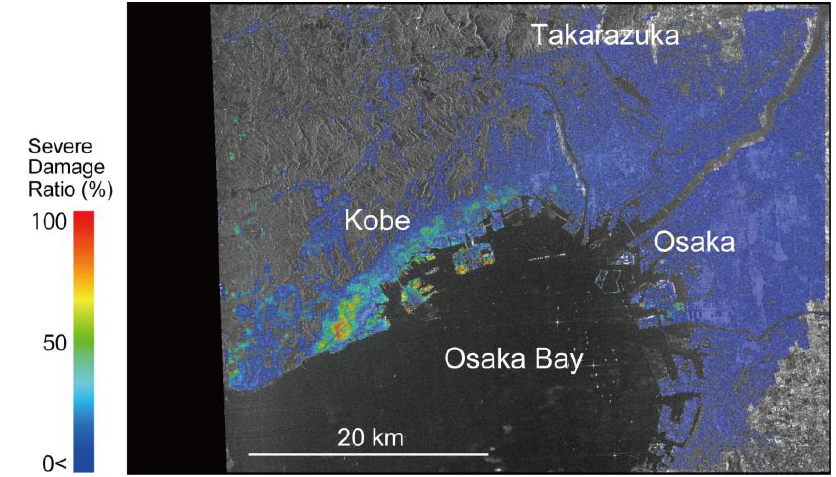
Figure 11. Distribution of estimated severe damage ratios (average values), estimated from an integrated processing of the discriminant score Z seismic intensity